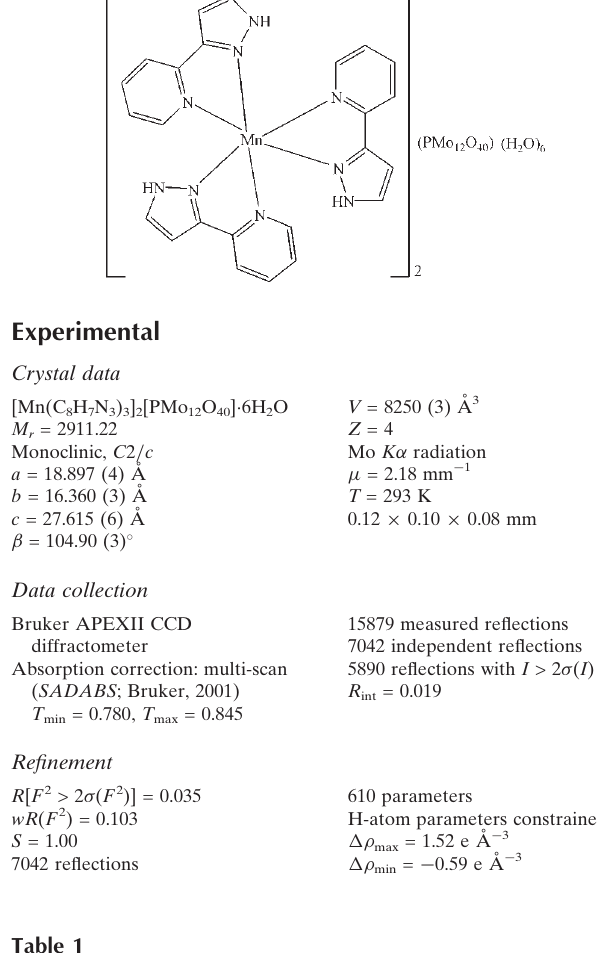
Selected bond lengths (A˚ ).